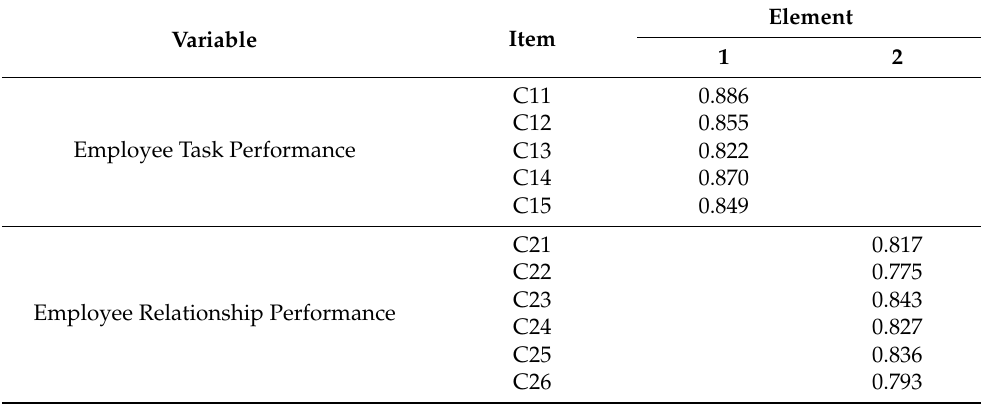
Table A6. Rotated Composition Matrix of Employee Work